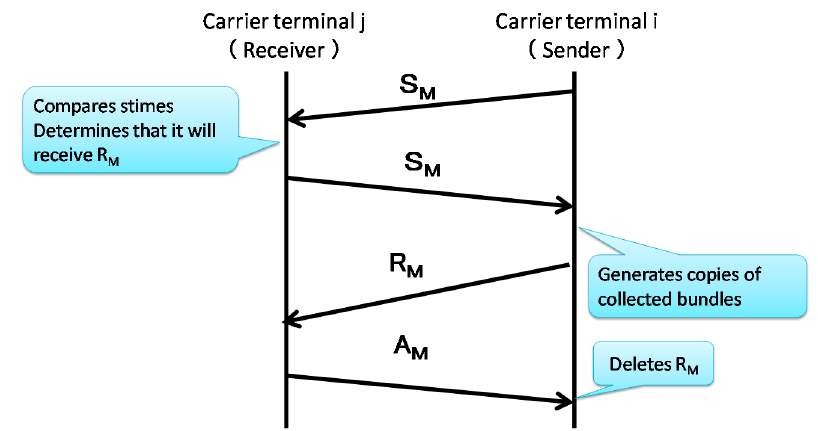
Figure 5. Sequence of inter-carrier terminal communication (from C j to C i ).